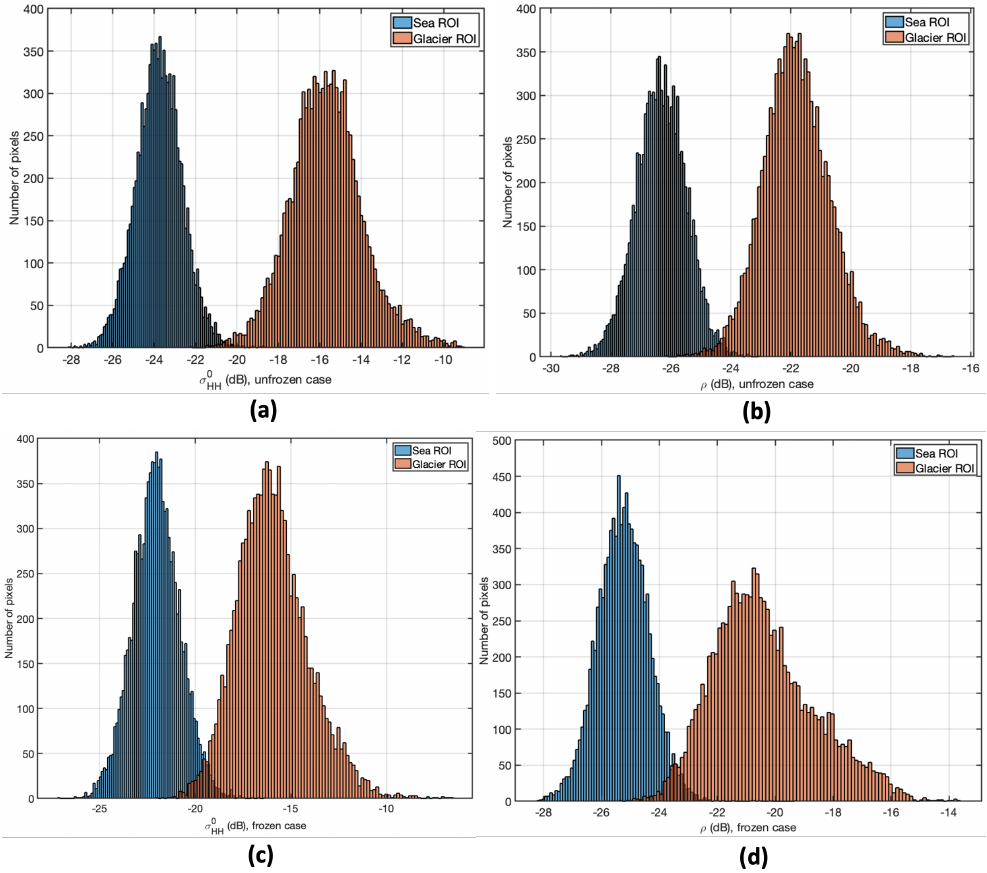
Figure 4. Statistical behaviours of single- and dual-polarimetric features evaluated for the 10 4 samples belonging to the selected ice-free and ice-infested seas (in blue) and glacier (in orange) ROIs. Rows refer to histograms estimated for the unfrozen ( a , b ) and frozen cases ( c , d ), respectively, whereas columns refer to histograms obtained from σ 0 ( a , c ) and ρ ( b , d ), respectively. The corresponding HH mean and standard deviation values are listed in Table